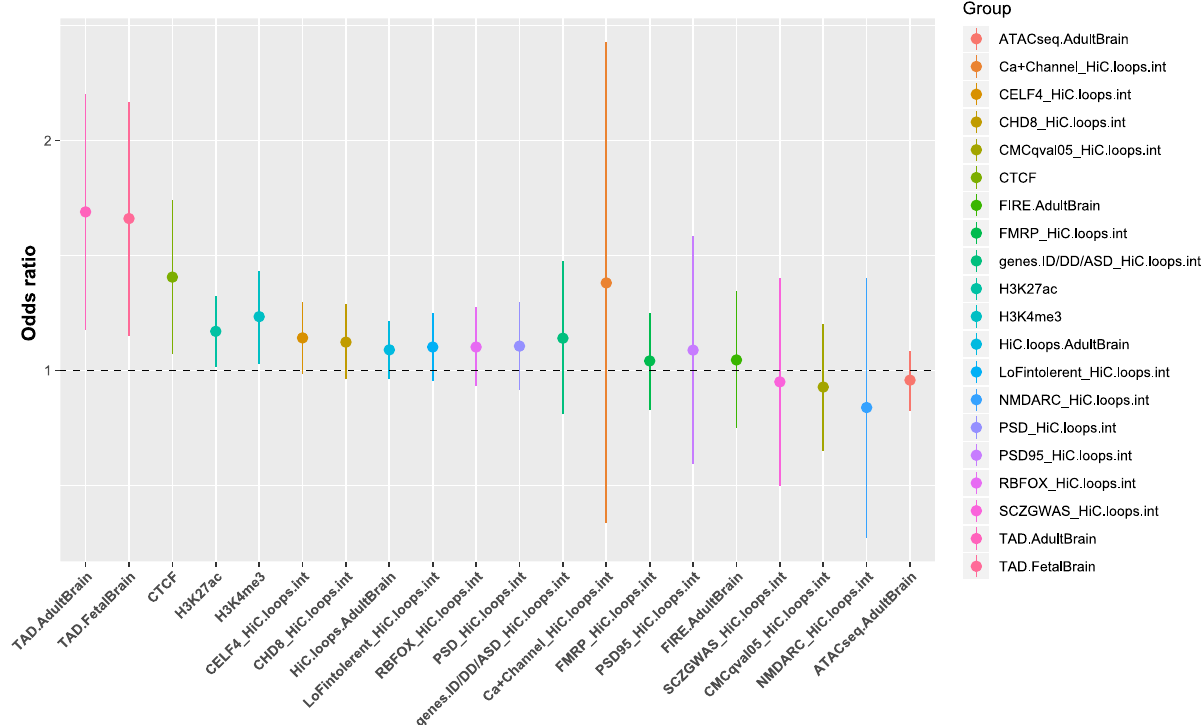
Fig. 3 Burden of ultra-rare SVs in brain epigenomic annotations and related analysis. For each speci fi c burden test, we use a vertical line to indicate the 95% con fi dence interval of odds ratio and a dot at the center of the vertical line to indicate the point estimate of odds ratio. Labels on X -axis indicate the speci fi c annotations that were considered. “ TADbou ” : TAD boundaries. Epigenomic annotations include TADbou.AdultBrain, TADbou.FetalBrain, ATACseq.AdultBrain, FIRE.AdultBrain, CTCF, H3K27ac, and H3K4me3. Regulatory elements connected with schizophrenia risk loci are labeled as “ gene. set.name_HiC.loops.int ” . For example, “ CELF4_ HiC.loops.int ” means regulatory elements of the CELF4 gene set identi fi ed via chromatin interaction (a.k.a HiC loops) data in human brain. Detailed information about gene sets considered can be found in Methods. Amongst the loci tested, only TAD boundaries derived from both fetal and adult brain tissue showed a signi fi cant degree of evidence for excess in cases relative to